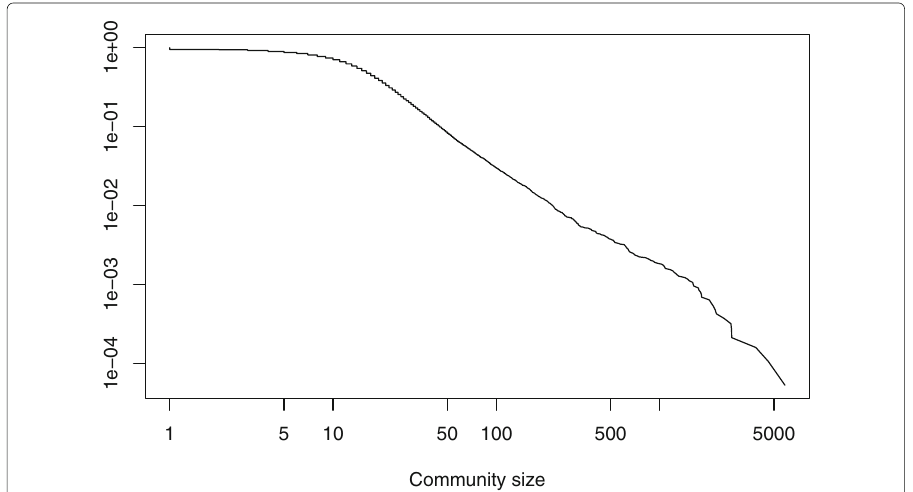
Fig. 9 Size distribution of communities in the circular flow network on the GSCC of the transaction